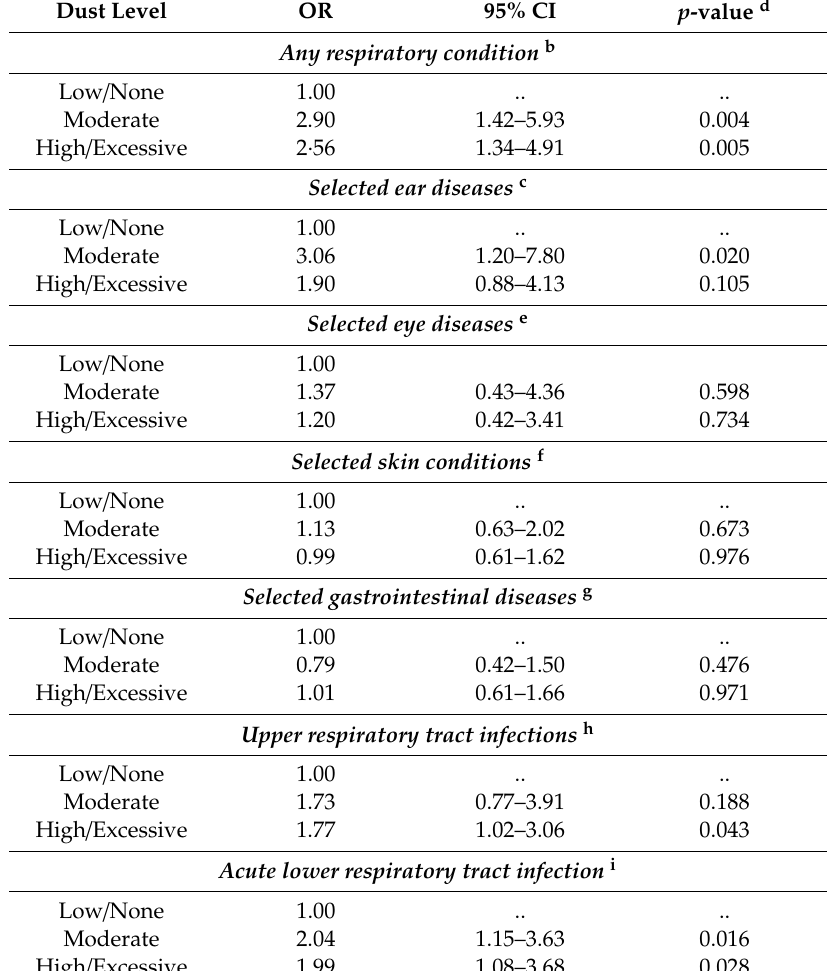
Table 2. Relationships between the perceived level of dust (EHNS) in the community and selected health outcomes (HMDS) among Indigenous children aged 0–17 years in discrete communities of Western Australia, 2000–2002 a